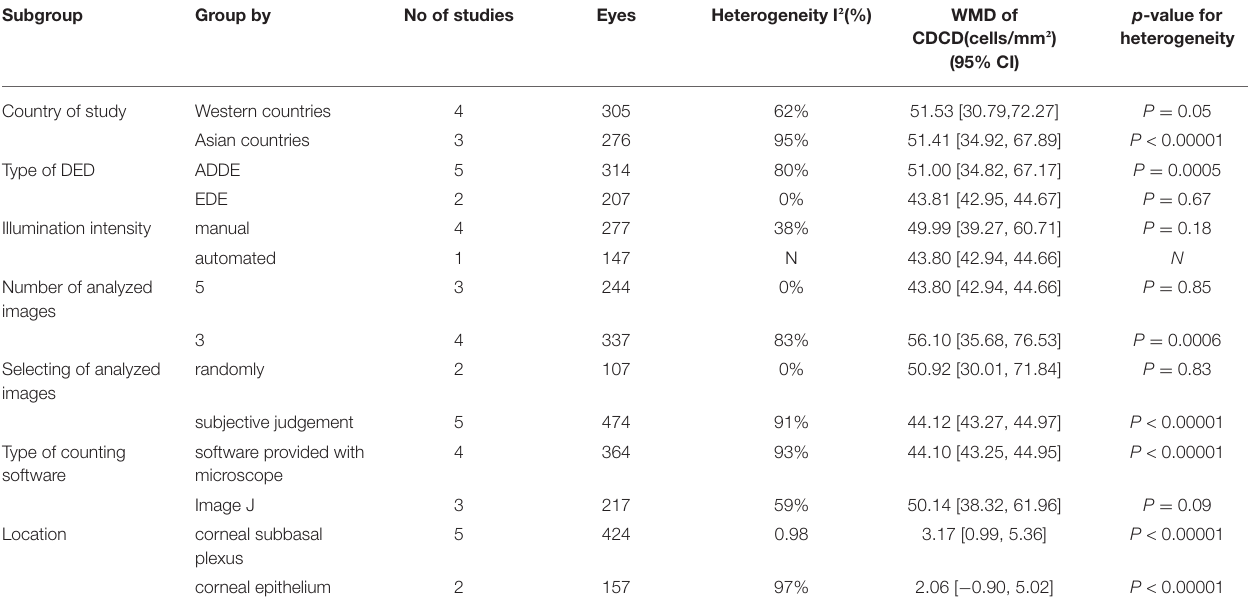
TABLE 1 | CDCD in the central cornea by various subgroup meta-analyses. Subgroup